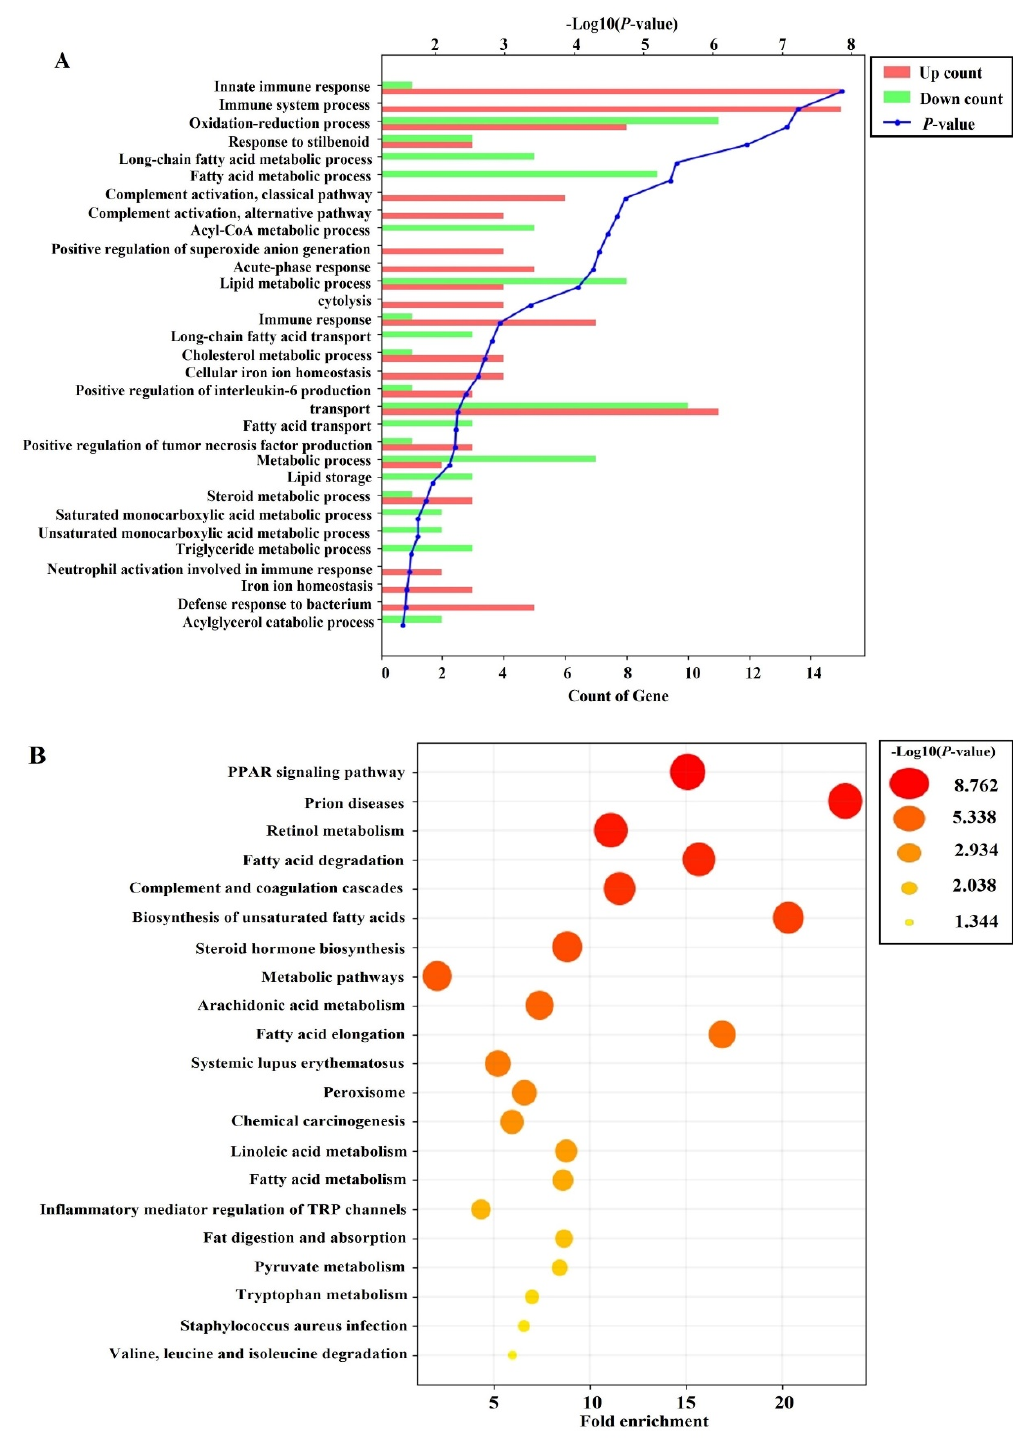
Figure 7. Effects of PRF administration on the liver transcriptome in HFD-induced obese mice. ( A ) Gene Ontology (GO) analysis using differentially expressed genes (DEGs) between the PRF 50 and HFD groups. Top 30 terms within the biological process category of GO function analysis. ( B ) Kyoto Encyclopedia of Genes and Genomes (KEGG) pathway analysis using DEGs between the PRF 50 and HFD groups. Top 20 terms among KEGG pathways. A p -value < 0.05 was considered to reflect statistical significance.